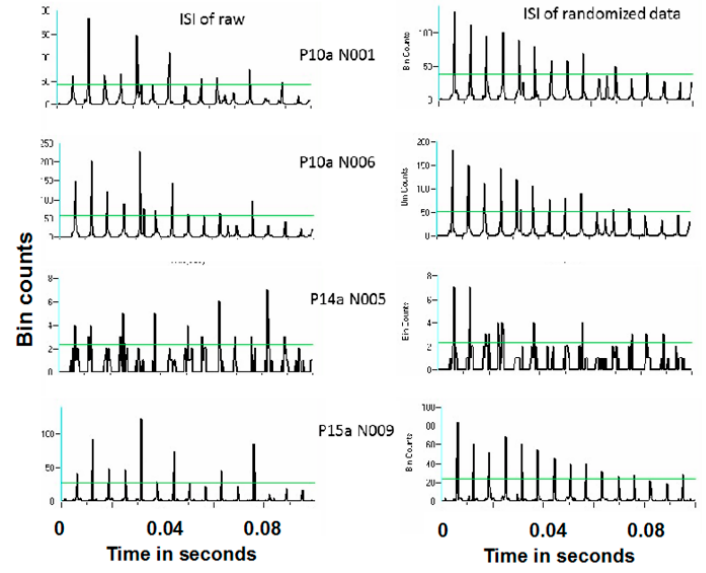
Figure 16. Representative interspike interval histogram of a antidromic-only spike train and its randomized-only spike train counterpart for 160 pps DBS.